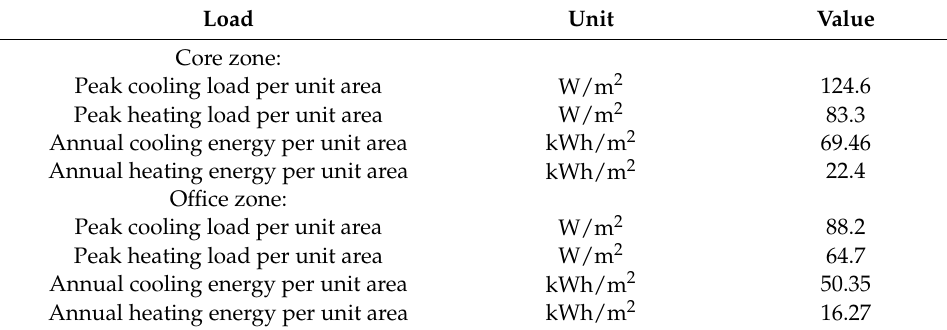
Table 10. Simulation results of the cooling and heating